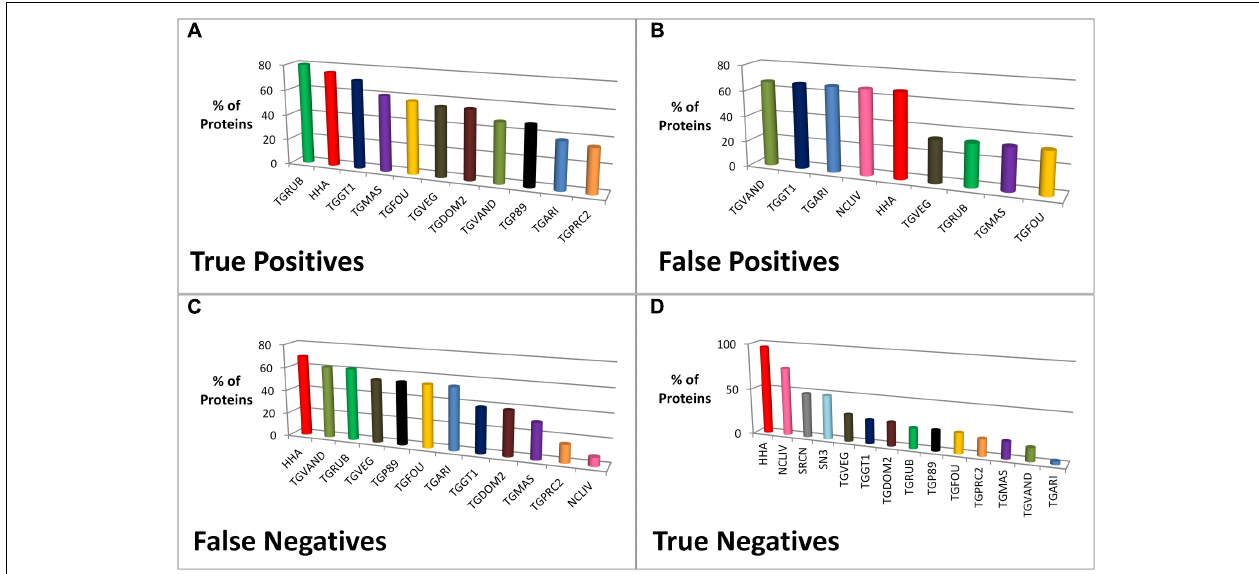
FIGURE 5 | The percentage of proteins from a species or strain contributing to the prediction of T. gondii ME49 vaccine candidates (meanings of species abbreviations shown in Table 1 ). The graphs (A–D) illustrate the percentage of proteins from representative species or strains of the 16 species dataset contributing to ortholog groups. More specifically, it shows the collective contribution to recipient ortholog groups associated with the prediction outcomes (true positives, false positives, false negatives, and true negatives) when predicting vaccine candidates for T. gondii ME49. For example, in graph [A] 40 out of 143 ortholog groups contain a T. gondii ME49 protein that was correctly predicted as a candidate, i.e., a true positive. The species Hammondia hammondi strain H.H.34 (HHA) contributes a protein to 75% of ortholog groups containing a true positive protein, i.e., 30 of the 40 groups contain a HHA protein.